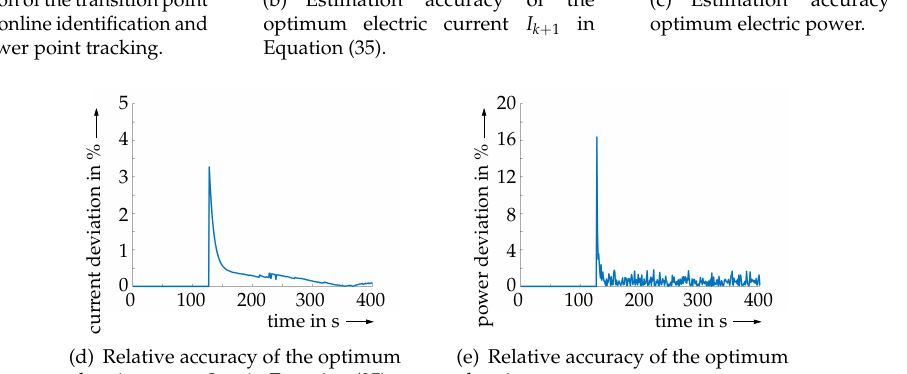
(d) Relative accuracy of the optimum (e) Relative accuracy of the optimum electric current I k + 1 in Equation (35). electric power. Figure 10. Validation of the Kalman filter-based maximum power point tracking procedure; relative deviations in Figure 10d,e are only reasonable for the phase in which the maximum power point tracking (MPPT) is active. In inactive phases, they are purposefully set to